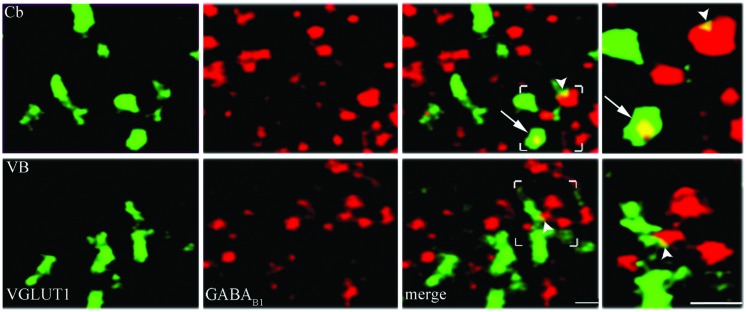
Control analysis of confocal microscopy images. VGLUT1/GABAB1 in molecular layer of cerebellum (Cb) and in ventrobasal complex (VB). Puncta were considered double-labeled when overlap was virtually complete or when a given punctum was entirely included in the other puncta (arrows in third and fourth columns). Puncta that did not meet these criteria (arrowheads) were not considered double-labeled; Bars: 2 μm.